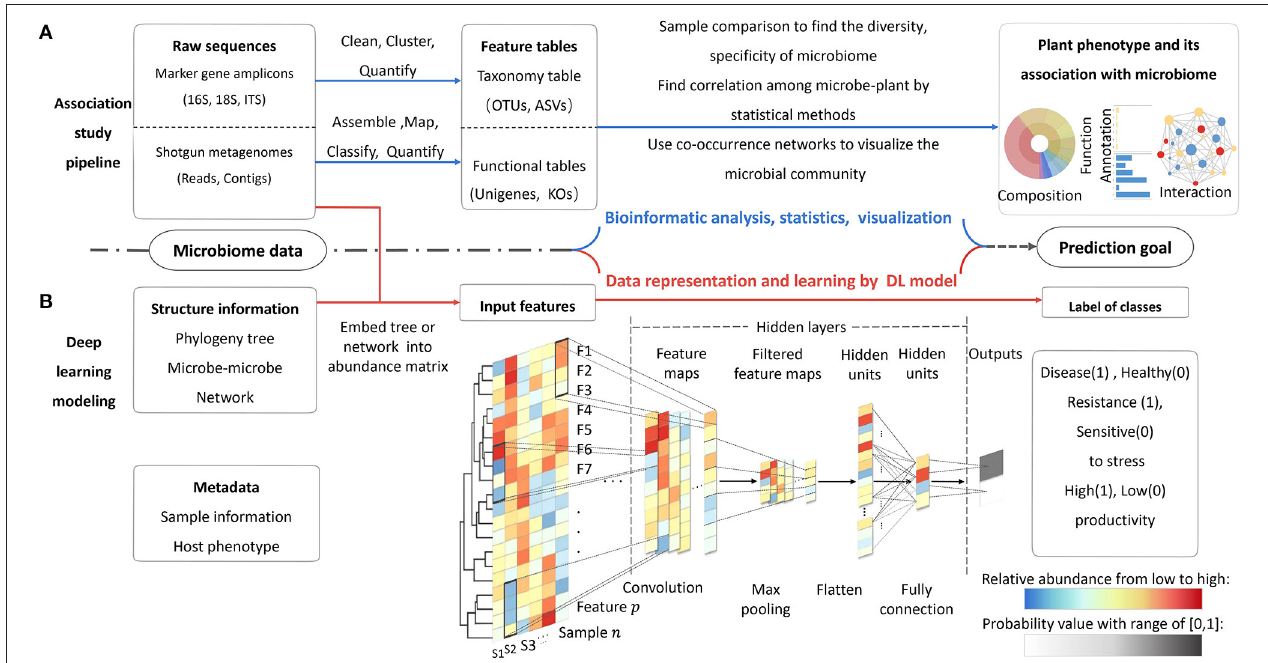
FIGURE 2 | Two routes of microbiome data analysis. (A) The processes of traditional association study by bioinformatics tools. (B) The processes of microbiome–phenotype connection by DL model. The model can integrate more information of data at the same time. In this example, a binary-classification CNN model, in which the abundance of features matrix is input and the outputs are the probability values of two class labels (0, 1). In hidden layers, operations of convolution and maximum pooling can extract the informative features by auto-updating the weight of each unit (feature). The filters in the black window down-sweep the input feature and get new matrices for each sample. The exact number of layers will be decided according to prediction accuracy about 3–5 layers based on experience. The last two layers are fully connected with their weight. The weights of connection represent the importance values of the units, as shown by the black dotted line with different color depths. Activation function at last layer can produce the probability vector that can be used for the final classification or